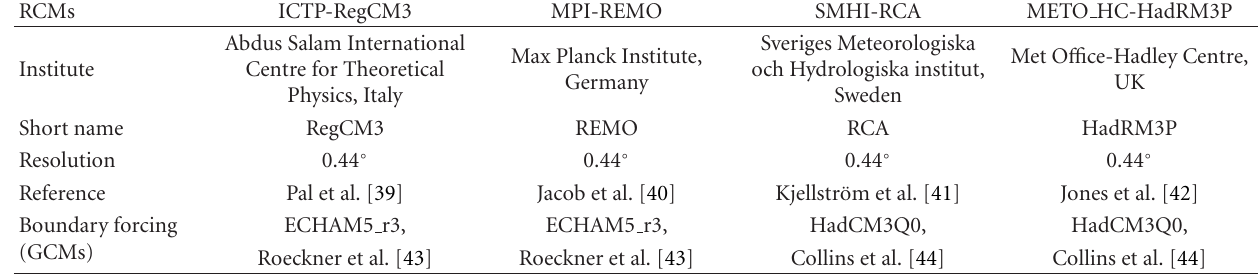
Table 1: List of regional climate models (RCMs) along with the driving global climate models (GCMs).